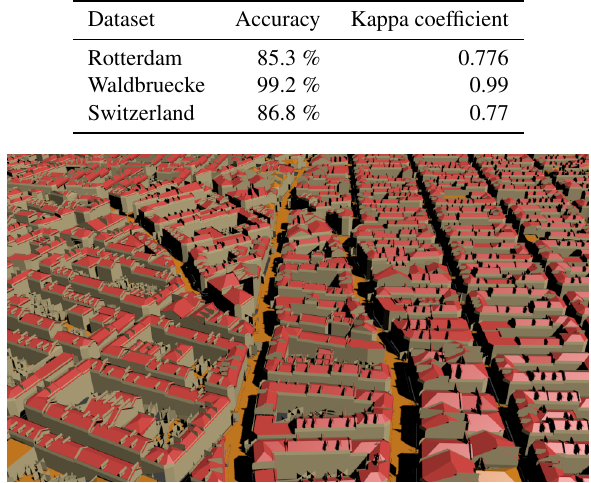
Figure 10: Semantically labelled 3D city model of Paris. The ter- rain polygons (orange) are thematically distinguished from build- ing surfaces.